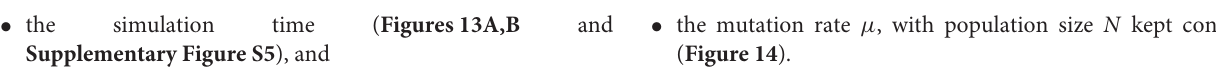
• the mutation rate µ , with population size N kept constant ( Figure 14